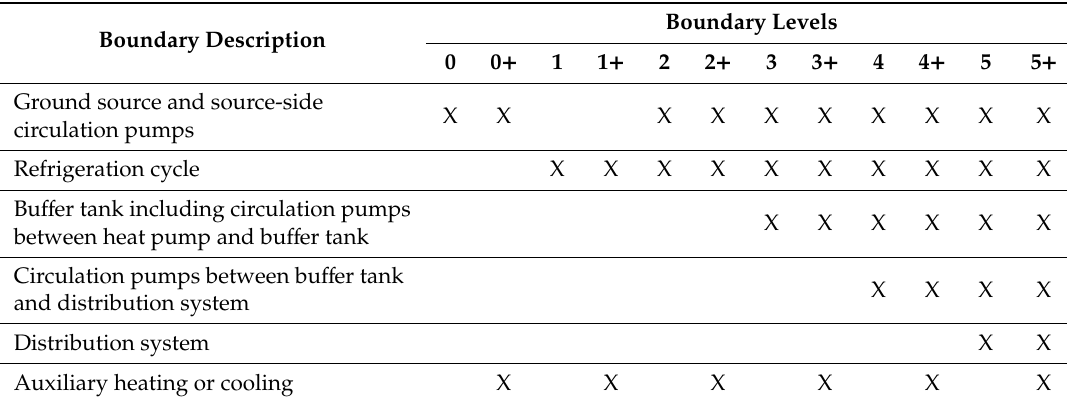
Table 2. Annex 52 system boundary